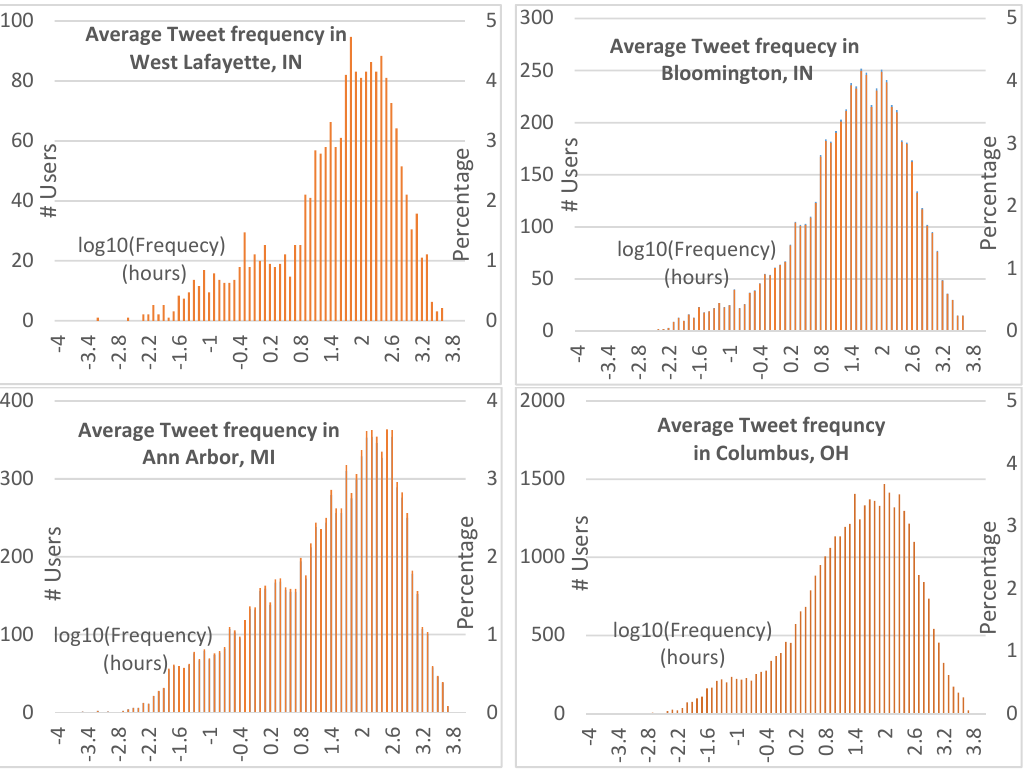
Figure 6. Number (in count and percentage) of users versus tweet frequency (in logarithm hours)